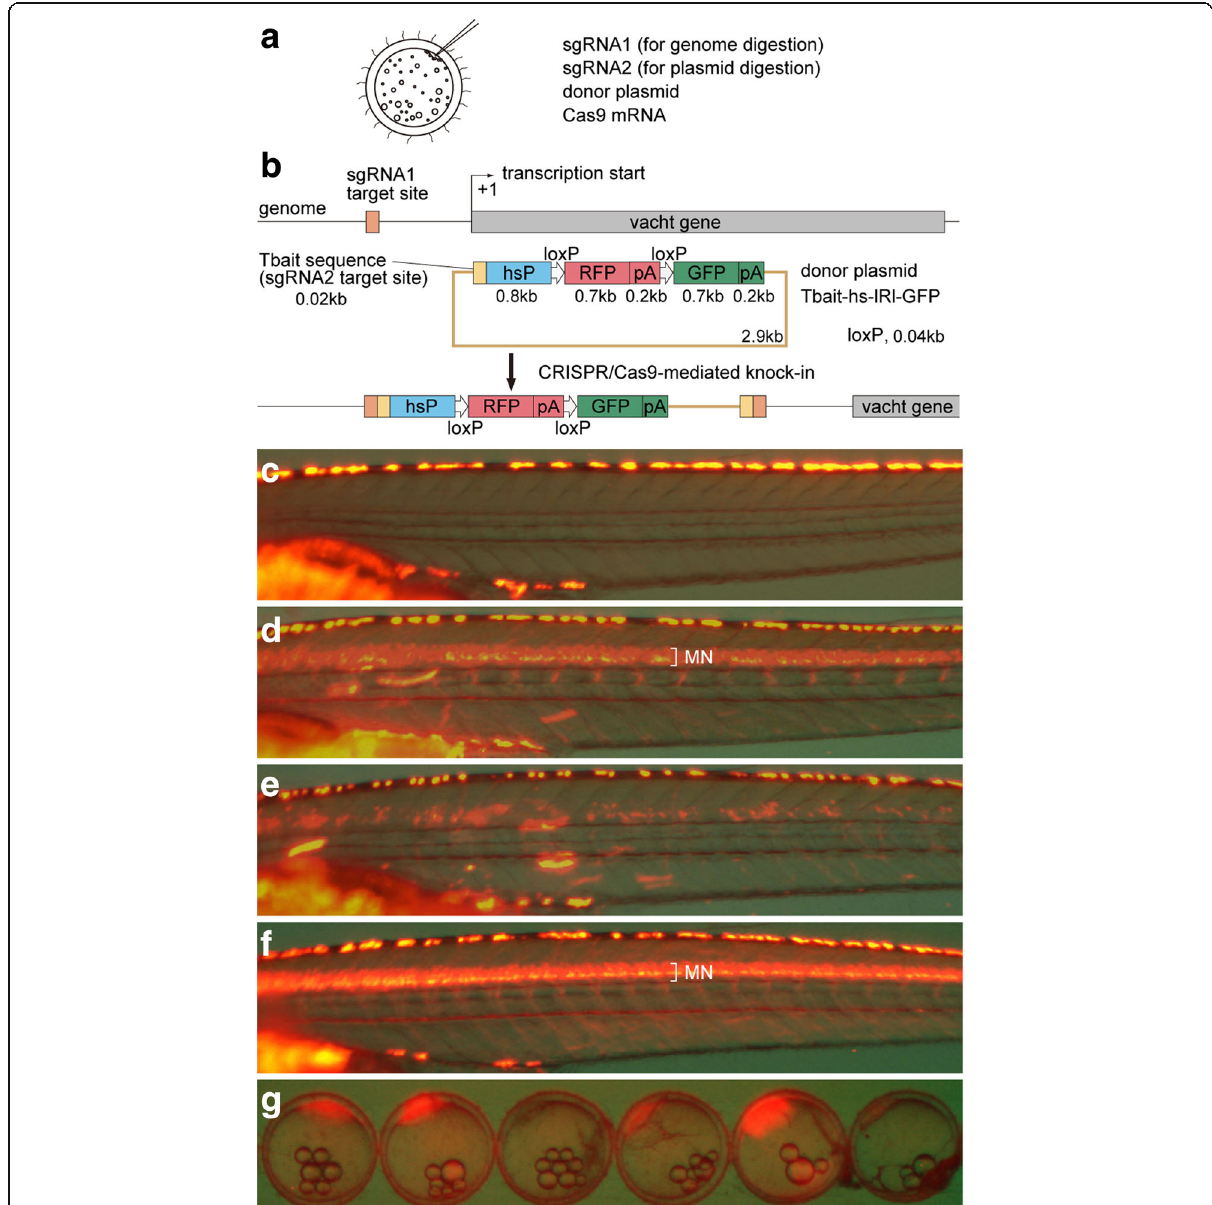
Fig. 1 Strategy for the generation of knock-in medaka and generation of Tg[vacht-hs:lRl-GFP] strains. ( a ) For the generation of knock-in transgenic fish, sgRNA1 (for genome digestion), sgRNA2 (for plasmid digestion), donor plasmid with a bait sequence, and Cas9 mRNA are co-injected into one-cell-stage medaka embryos. ( b ) A schematic representation of the vacht locus (grey box) and the sgRNA target sites (orange box), and the reporter gene construct consisting of the Tbait (brown box), medaka hsp70 promoter (hsP, blue box), loxP, RFP-pA (red box), loxP, and GFP-pA (green box). After injection, the concurrent cleavage of the targeted genomic locus and the Tbait-hs-lRl-GFP reporter plasmid results in the integration of the reporter by non-homologous end joining (NHEJ). The scheme shows the forward integration of the reporter. ( c ) Lateral view (red fluorescence) of a control larva at 9dpf. Red-yellow signals in the dorsal region of the body are from the auto-fluorescence of pigment cells. ( d ) An example of an injected larva. RFP expression was present broadly in the motoneurons (MN). Animals with this kind of RFP expression were judged as having “ good expression ” , and raised to adulthood. ( e ) Another example of an injected larva. In this animal, RFP expression was present in the motoneurons, but the number of RFP-expressing cells is much smaller than that in ( d ). Animals with this kind of RFP expression were judged as not having “ good expression ” , and were not raised. ( f ) Lateral view of a Tg[vacht-hs:lRl- GFP] larva. RFP expression was present broadly in the trunk motoneurons. All of the trunk motoneurons are likely to express RFP in this animal. ( g ) Maternal expression of RFP in early embryos in the Tg[vacht-hs:lRl-GFP] line. The expression levels of RFP are variable among embryos. The embryos were obtained from a single